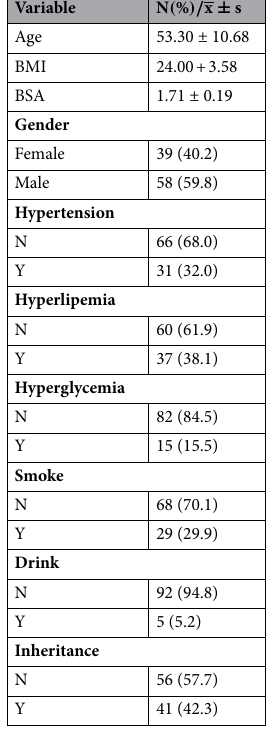
Table 1. General clinical